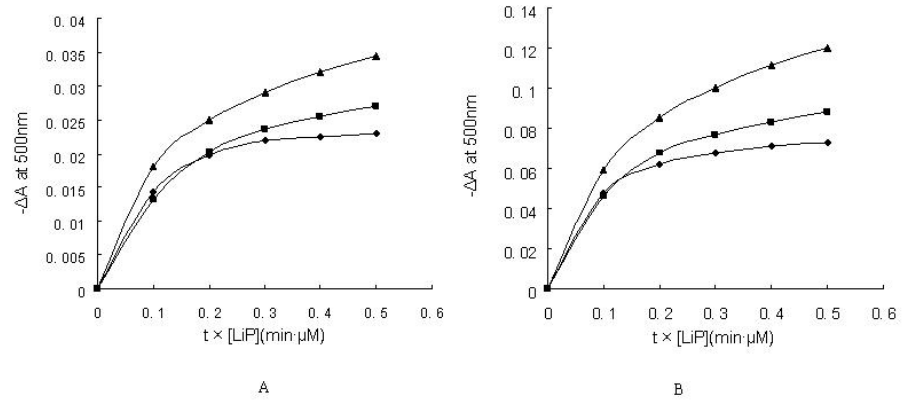
Fig. 6 Inactivation of LiP by H 2 O 2 in the absence (A) or presence (B) of VA during the LiP catalyzed oxidation of PR. Conditions: First, the A 500 − t curves of the LiP catalyzed oxidation of PR (40 μ M) initiated by H 2 O 2 (60 μ M) were recorded at several LiP con- centrations ([LiP] = 0.1 μ M